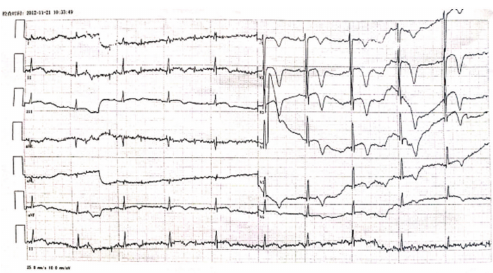
Figure 2: ECG 11 days after admission.